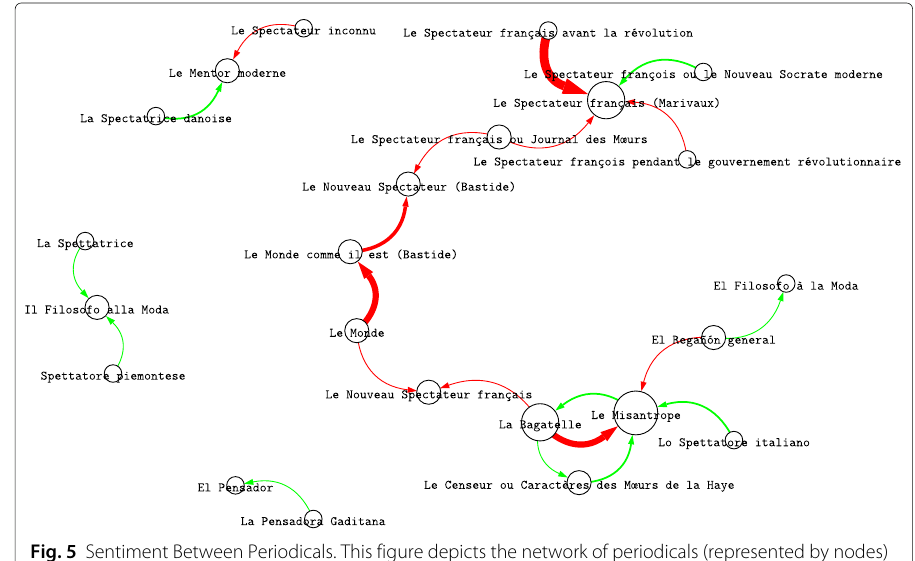
Fig. 5 Sentiment Between Periodicals. This figure depicts the network of periodicals (represented by nodes) referencing other periodicals contained in our dataset. Directed edges indicate if a periodical referenced other periodicals and the color of edges illustrates the mean standardized sentiment of the text passages in which a respective periodical was referenced. Node sizes represent the degree of periodicals and edge widths represent the multiplicity of